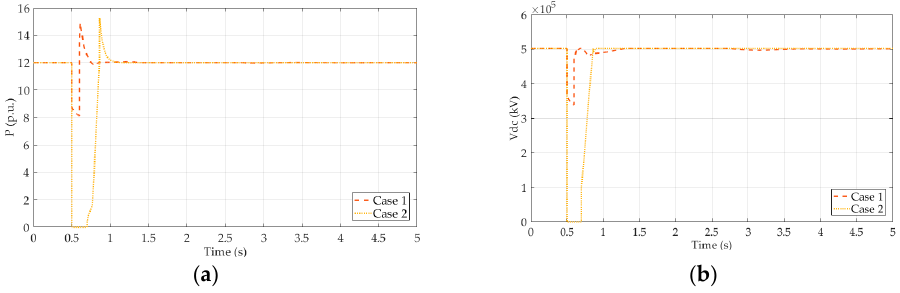
Figure 12. New HVDC system performance from the transient stability simulation: ( a ) active power transmission; ( b ) DC voltage of rectifier.